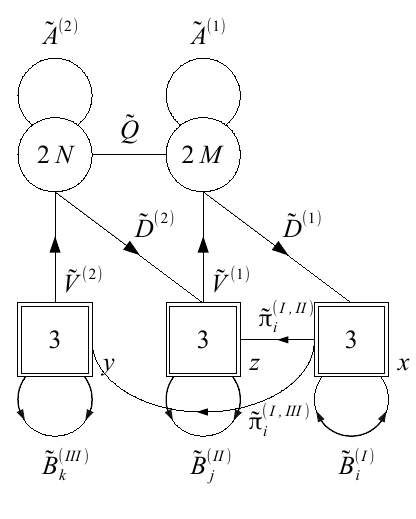
Figure 10 . The quiver diagram for Theory